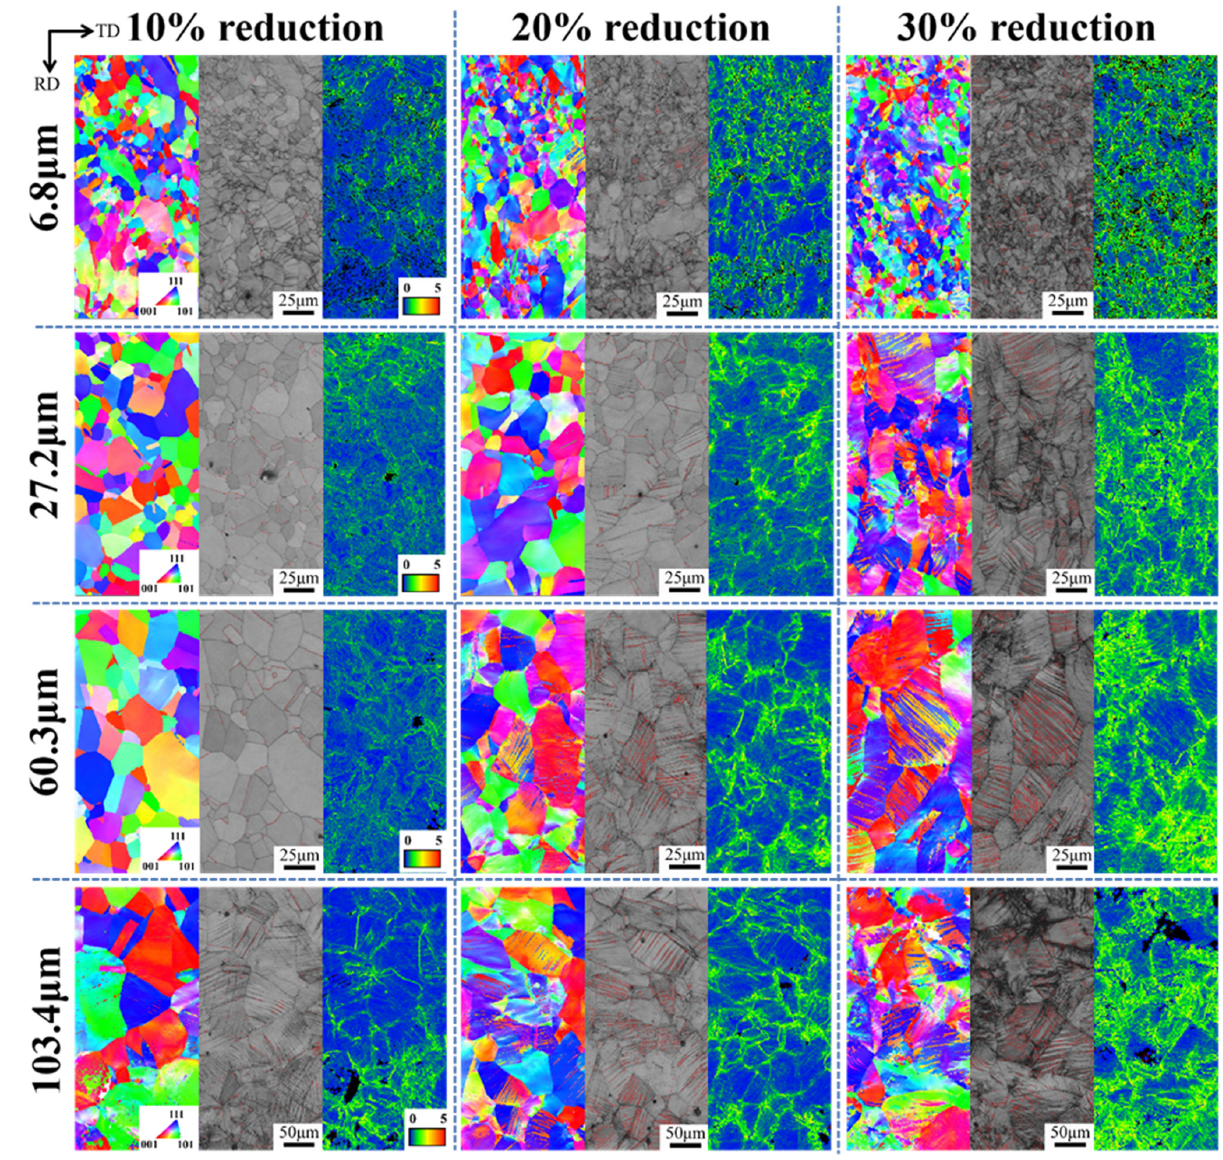
Figure 11. IPF, IQ (twin boundaries are marked by red lines) and KAM maps of annealed samples with different grain sizes after rolling.